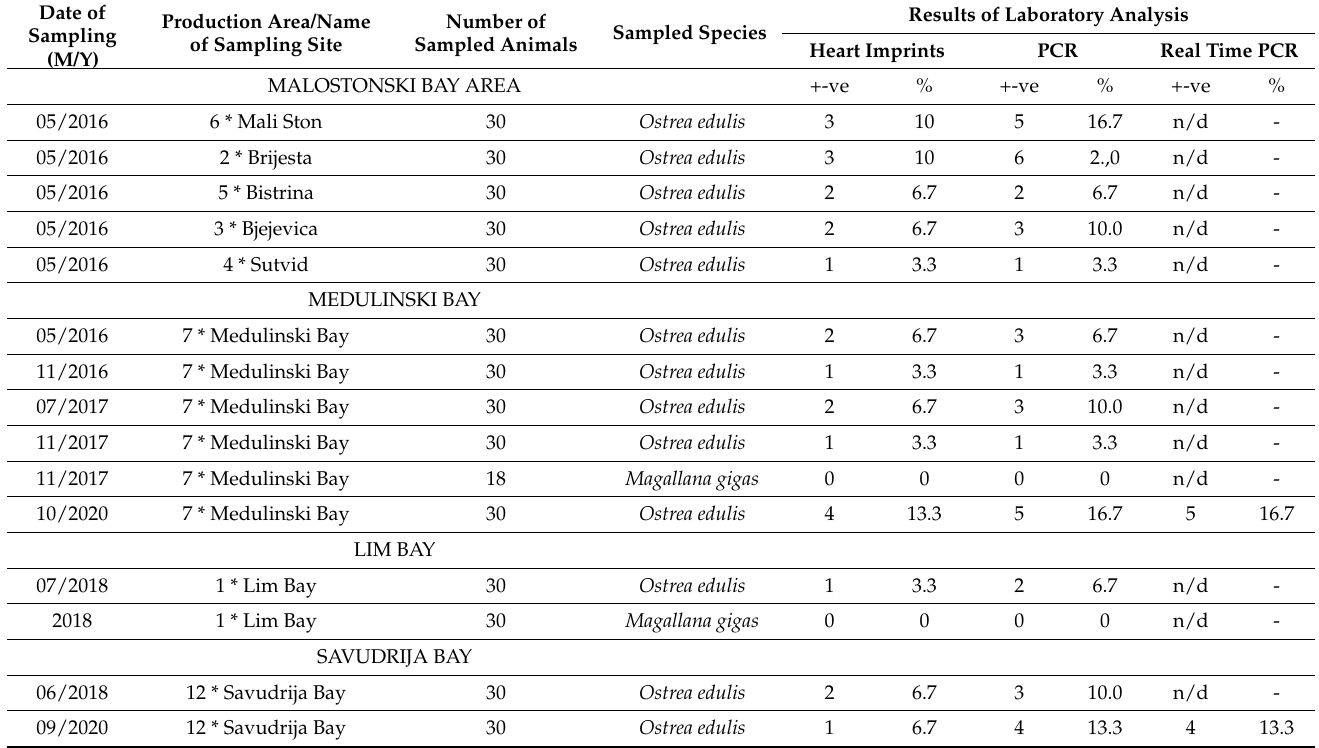
Table 2. Total number of oysters analyzed for the presence of Bonamia spp. in the period